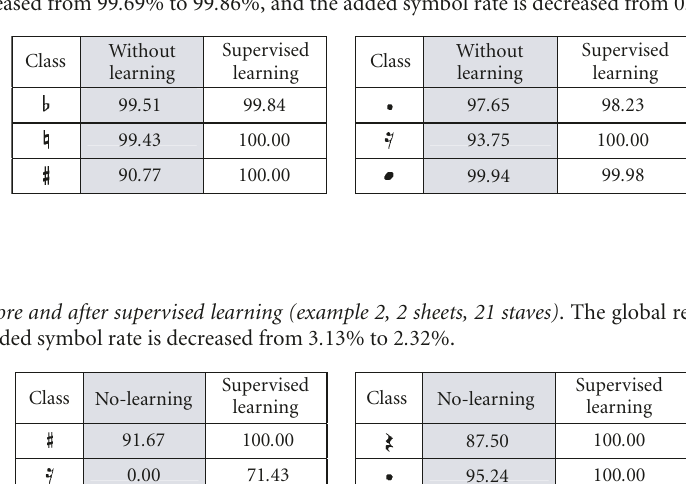
Table 6: Recognition rates before and after supervised learning (example 1, 16 sheets) . The other symbol recognition rates are identical. The global recognition rate is increased from 99 . 69% to 99 . 86%, and the added symbol rate is decreased from 0 . 53% to 0 . 11%.